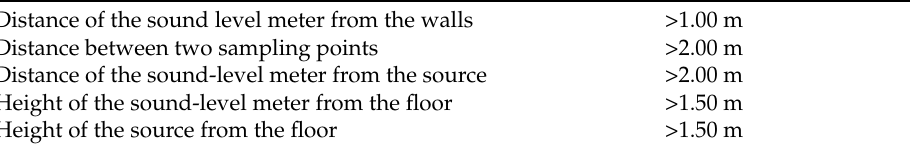
Table 7. Criteria for the exact positioning of the source and the sound level meter. Distance of the sound level meter from the walls >1.00 m Distance between two sampling points >2.00 m Distance of the sound-level meter from the source >2.00 m Height of the sound-level meter from the floor >1.50